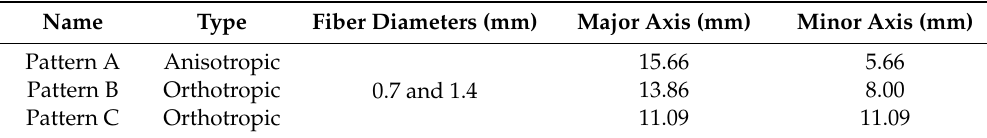
Table 3. Pattern